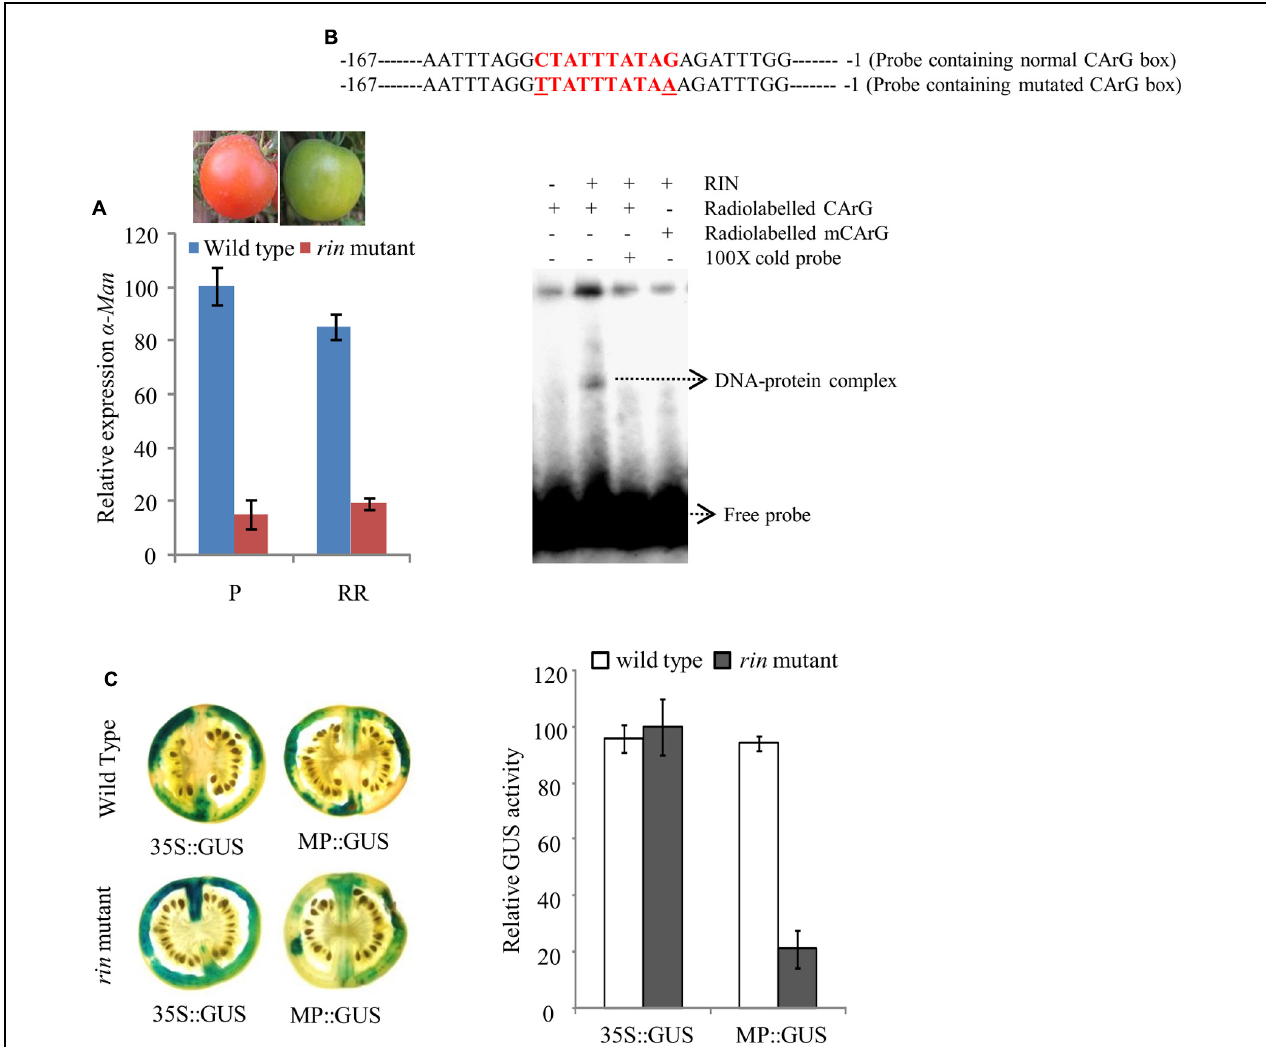
FIGURE 5 | RIN regulated expression of α -Man in fruit. (A) Relative transcript abundance of α -Man in wild type (cv. Ailsa Craig) and rin mutant fruits was determined by qRT-PCR using tomato actin as endogenous control. (B) EMSA showing in vitro binding of RIN protein with the α -Man promoter. (C) CaMV35S and α -Man promoter driven expression of GUS in fruits of wild type and rin mutant. GUS activity in agroinjected fruits was analyzed by histochemical and fluorometric assays. Data are presented as the mean ( ± SE) of two biological